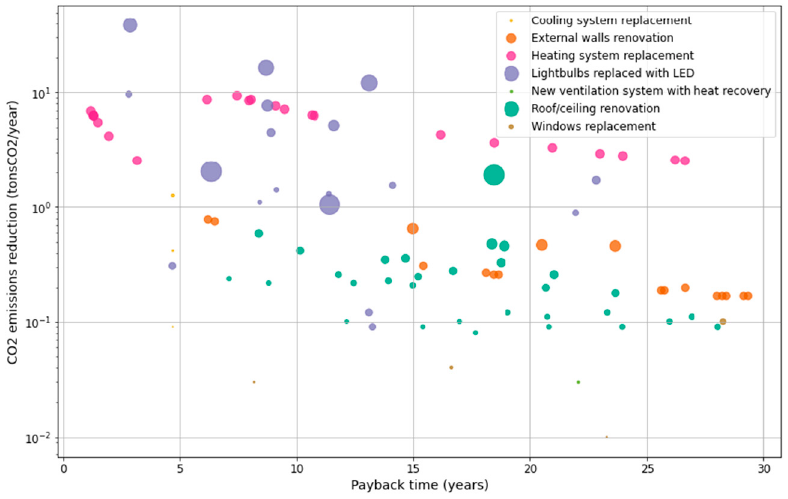
Figure 7. CO 2 emission reduction vs. the payback time of the proposed energy efficiency measures.